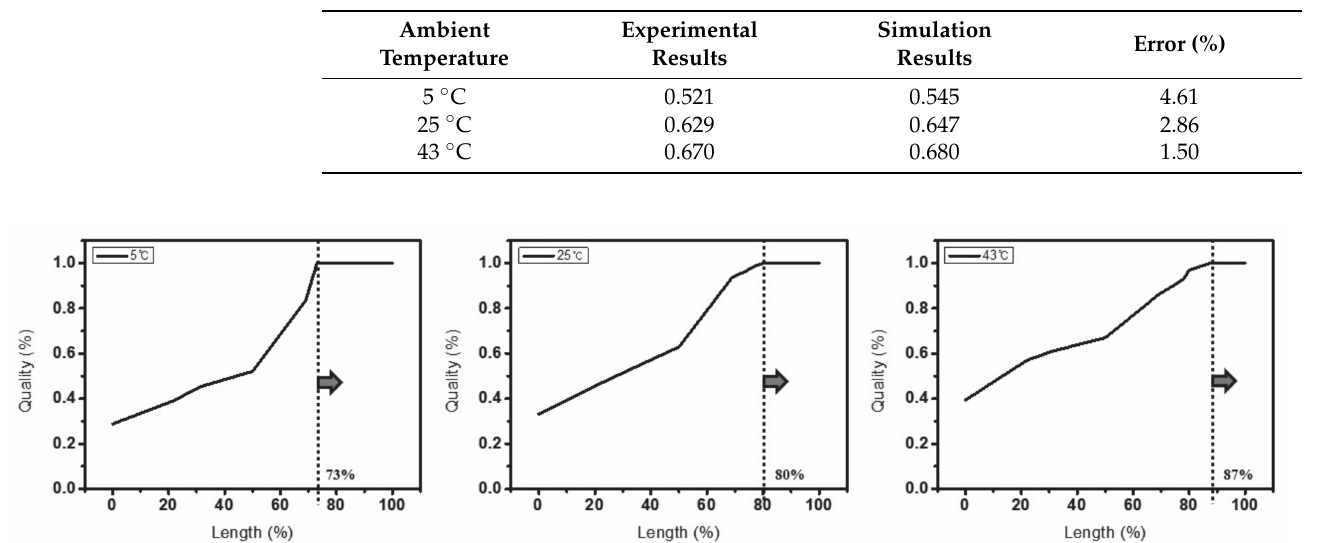
to the two-phase region, so it is possible to minimize the evaporator size based on the total amount of heat transfer. The area under the data-line reflects the total amount of heat transfer. The optimal evaporator size was determined as the limit point in which the performance does not change dramatically compared to the conventional evaporator size.